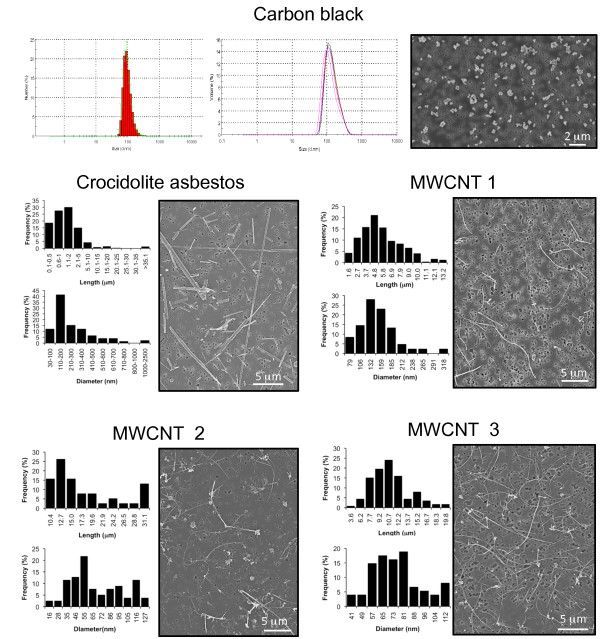
Size distribution in serum-free medium. Materials were dispersed in serum-free medium and collected onto a filter prior to cellular exposure shown by SEM imaging.